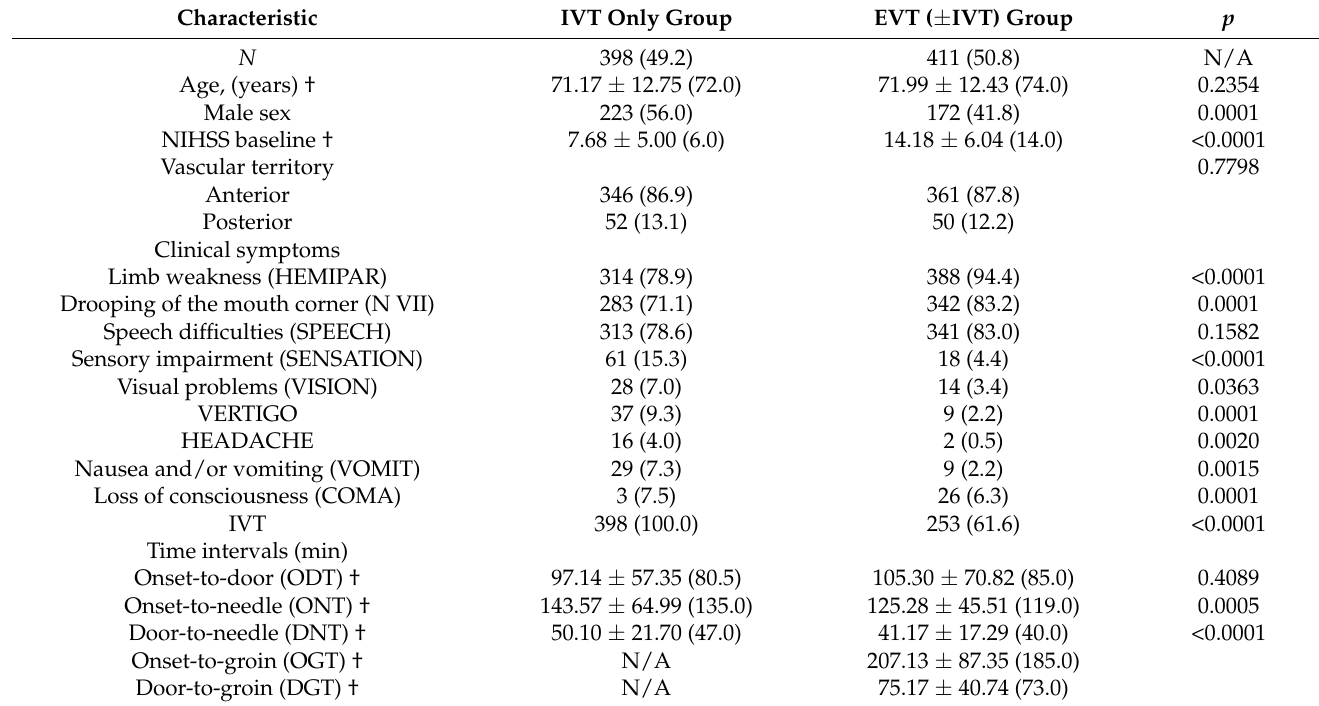
Table 1. Baseline and outcome characteristics.